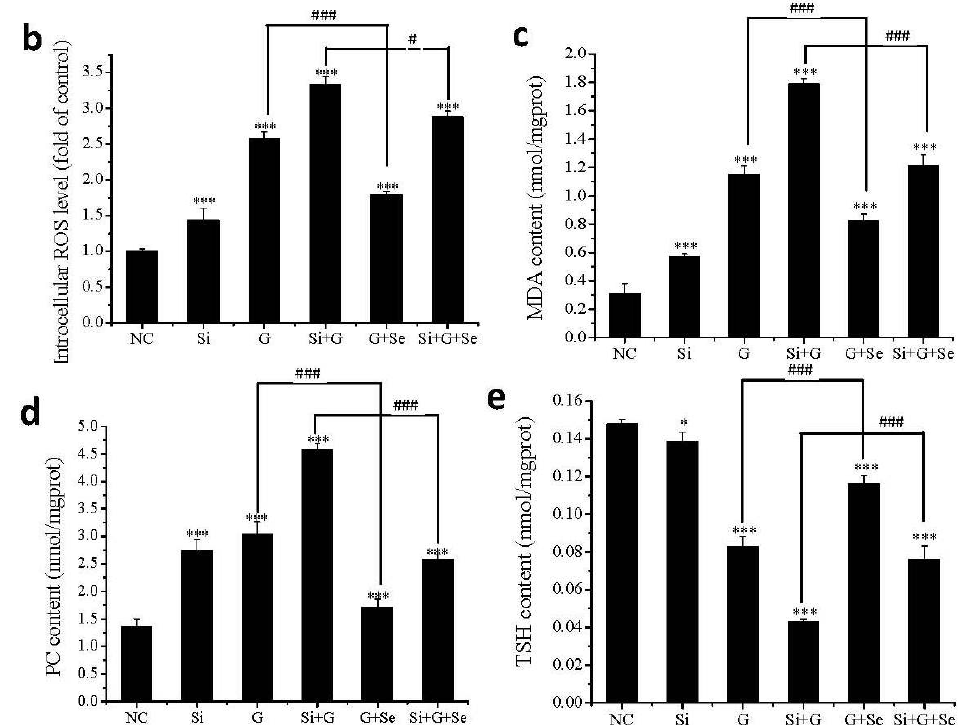
Figure 5. Alterations of intracellular reactive oxygen species (ROS), malondialdehyde (MDA), protein carbonyl (PC) and total mercapto group (TSH) levels. ( a ) Alterations of fluorescent intensity with ROS levels in the indicated group assayed by H 2 -DCFDA staining using fluorescent microscopy (200×); ( b ) Intracellular ROS levels in hLE cells in the indicated group; ( c ) Intracellular MDA levels in hLE cells in the indicated group; ( d ) Intracellular PC levels in hLE cells in the indicated group; ( e ) Intracellular TSH levels in hLE cells in the indicated group. Data are the mean ± SD of at least three independent experiments. * p < 0.05, *** p < 0.001, compared to the negative control group; # p < 0.05, ### p < 0.001. NC: negative control cells; Si: cells with SelR siRNA transfection for 24 h; G: cells exposed to D -galactose (150 mM) for 36 h; Si+G: cells with SelR siRNA transfection followed by D -galactose exposure; G+Se: cells exposed to D -galactose (150 mM) and Na 2 SeO 3 (1 μM) for 36 h; Si+G+Se: cells with SelR siRNA transfection followed by D -galactose and Na 2 SeO 3 exposure.